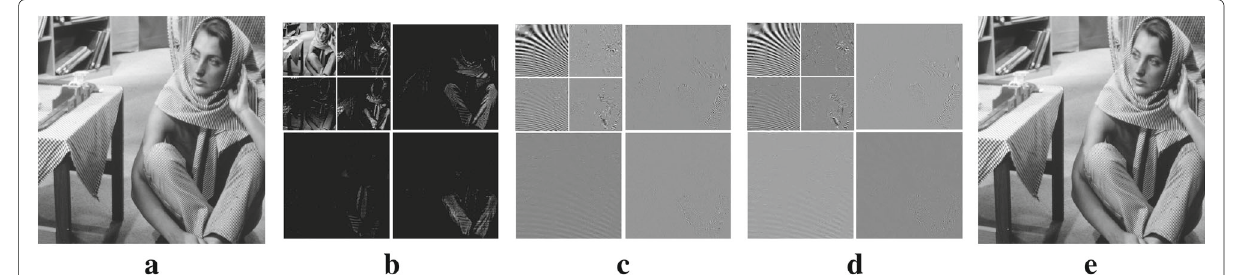
Fig. 15 Example of 2D DLCWT decomposition using db3 linear canonical wavelet with A / B = 200 in rows and A / B = − 100 in columns. a Original 512 × 512 ’Barbara.’ b Magnitude of two layers 2D DLCWT decomposition of ’Barbara.’ c Real part of two layers 2D DLCWT decomposition of ’Barbara.’ d Imaginary part of two layers 2D DLCWT decomposition of ’Barbara.’ e Reconstructed ’Barbara’